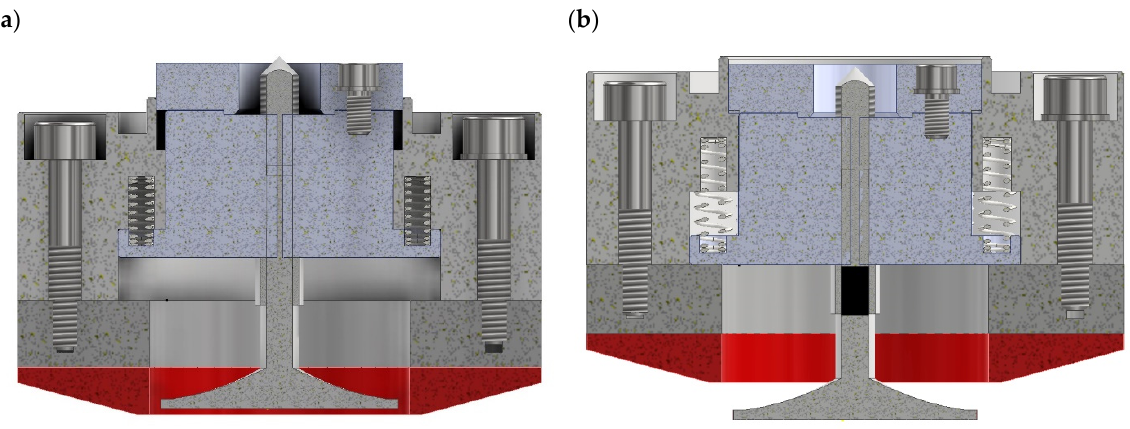
Figure 4. The 3D digital model of a dual-tool grinding head: ( a ) in the coarse grinding se tt ing; ( b ) in the fi nishing grinding se tt ing.